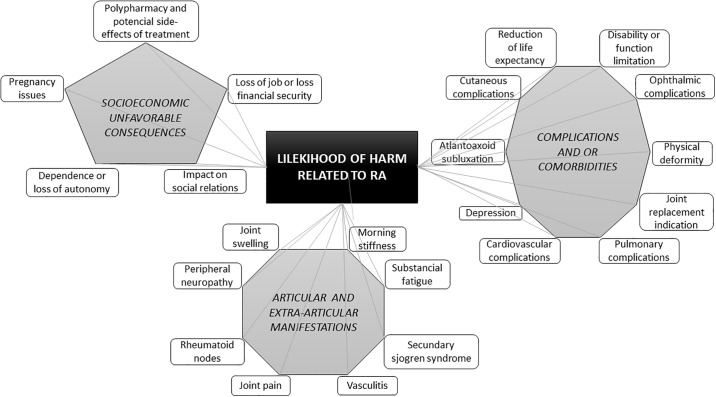
Semantic network graph for rheumatoid arthritis related articular and extra-articular manifestations, complications and/or comorbidities and socioeconomic unfavorable consequences.The figure is a schematic representation of the resulting network from the semantic network analysis. At the middle, the central concept and to the sides the network of objects extracted from patients interviews and healthcare providers and associated as related concepts.